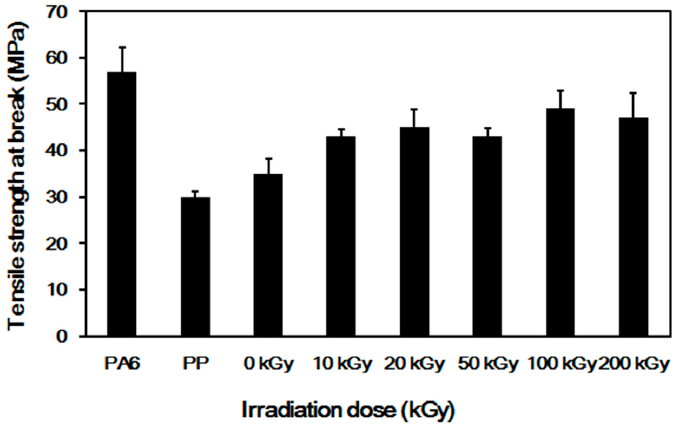
Figure 7. Effect of irradiation dose on the elongation at break of PA6/PP (80/20) blends.